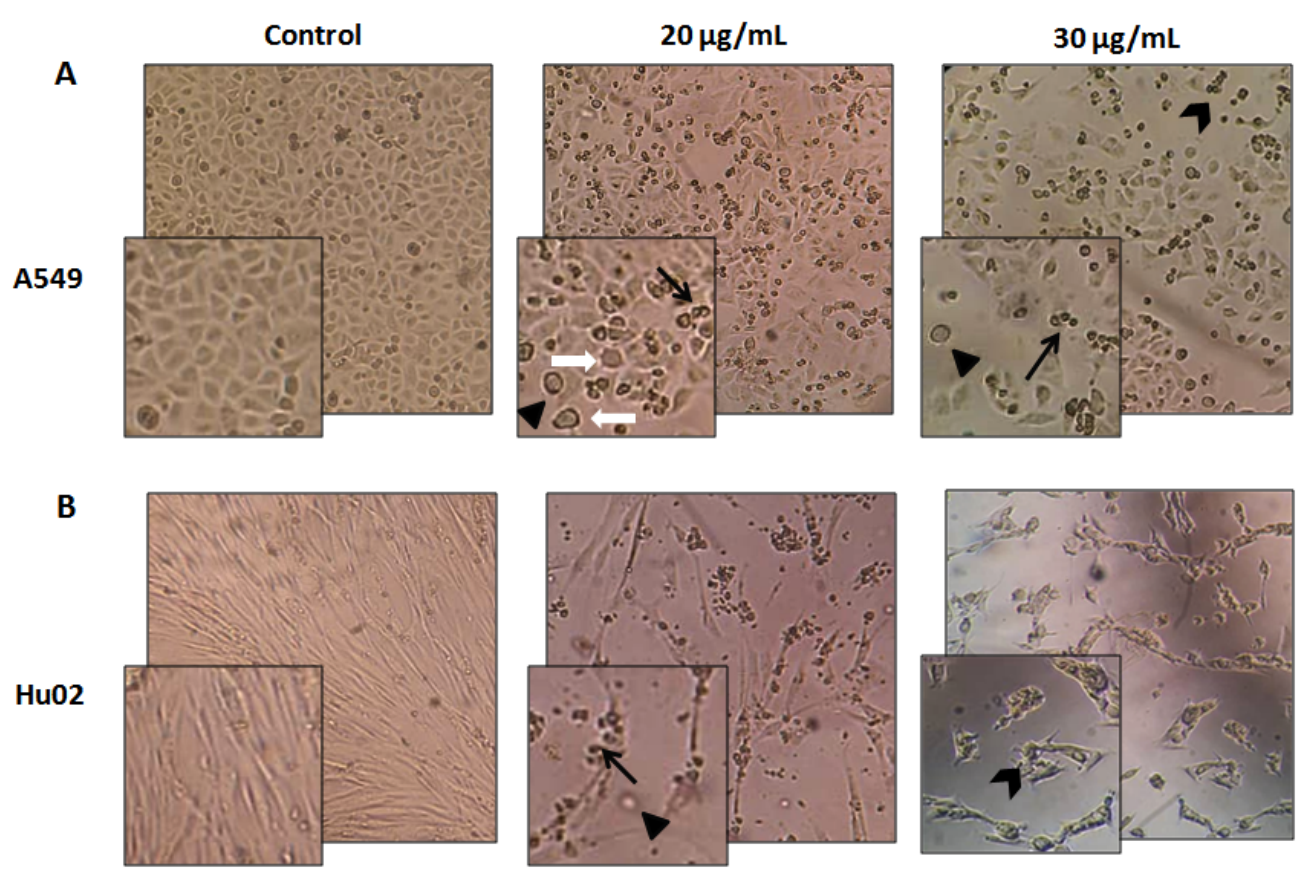
Figure 1. Morphological and cell growth assessment of ( A ) A549 and ( B ) Hu02 cells treated with P. persicus crude venom. Morphological differences in the cells were observed under Labomed TCM 400 inverted phase contrast microscope (magnification 100×) after treatment with 20 and 30 µg/mL of P. persicus crude venom for 24 hours. Control shows the untreated cells. Irregular shape of the cells (A549 normal cells), cell rounding (filled triangles), cellular debris (arrowheads), apoptotic bodies (black arrows) and cytoplasmic blebbing (white arrows) are observable in the venom treated